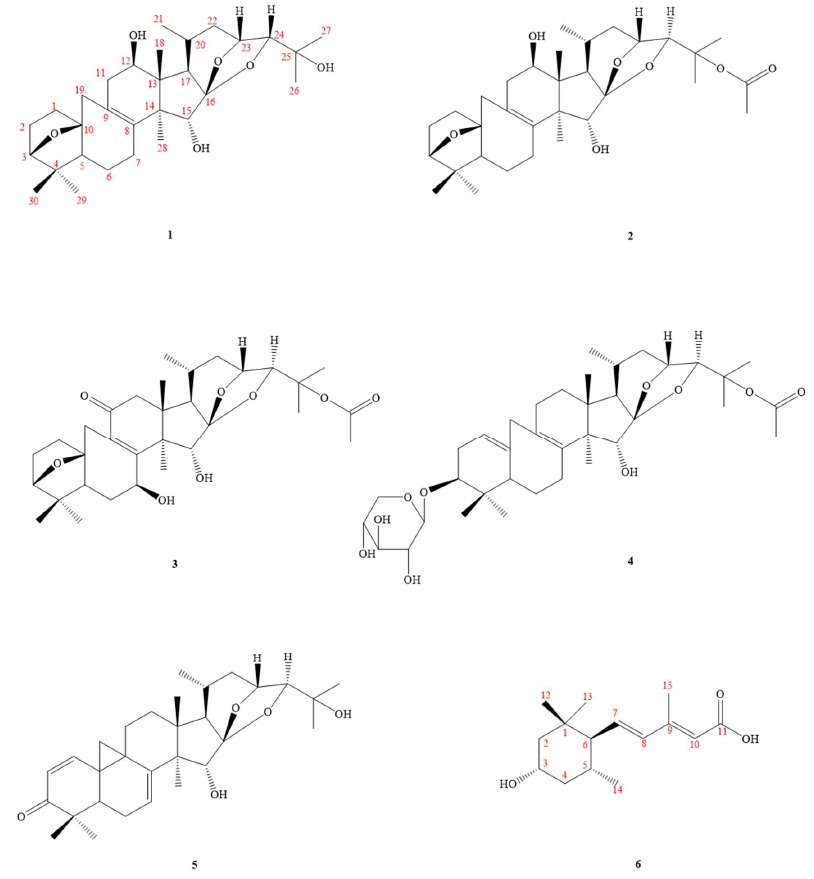
Figure 1. Compounds 1 – 6 , isolated from Cimicifuga taiwanensis .